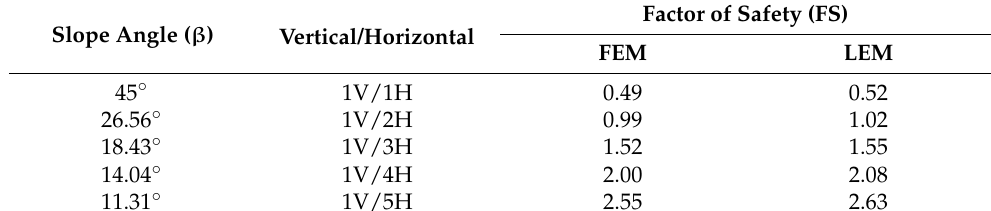
Table 5. Unreinforced analysis results.